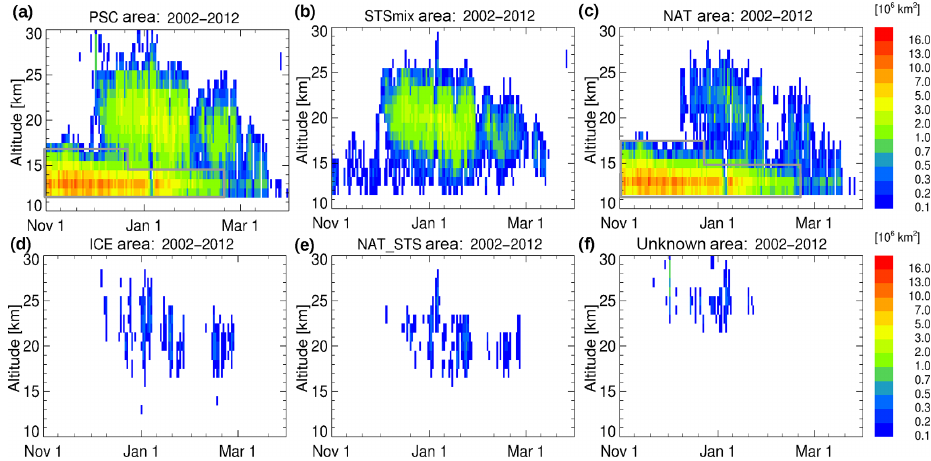
Figure 12. Time series of the northern polar mean 2002/2003 to 2011/2012 winter seasons of the daily Arctic area PSCs of the applied latitude bins north of 55 ◦ N in the altitude range 12–30km. This approach is equivalent to the partition of areal coverage north of 55 ◦ N. An altitude grid of 1km with 2km grid size is applied. Presented are the overall PSC coverage (a) and all relevant classes of the Bayesian classifier (ICE, NAT, STSmix, NAT_STS, and unknown) in panels (b–f) . The grey boxes highlight regions where volcanic aerosols in the UTLS have introduced a bias in the PSC detection and classification. The box is based on all winter (November–March) observations in the MIPAS measurement